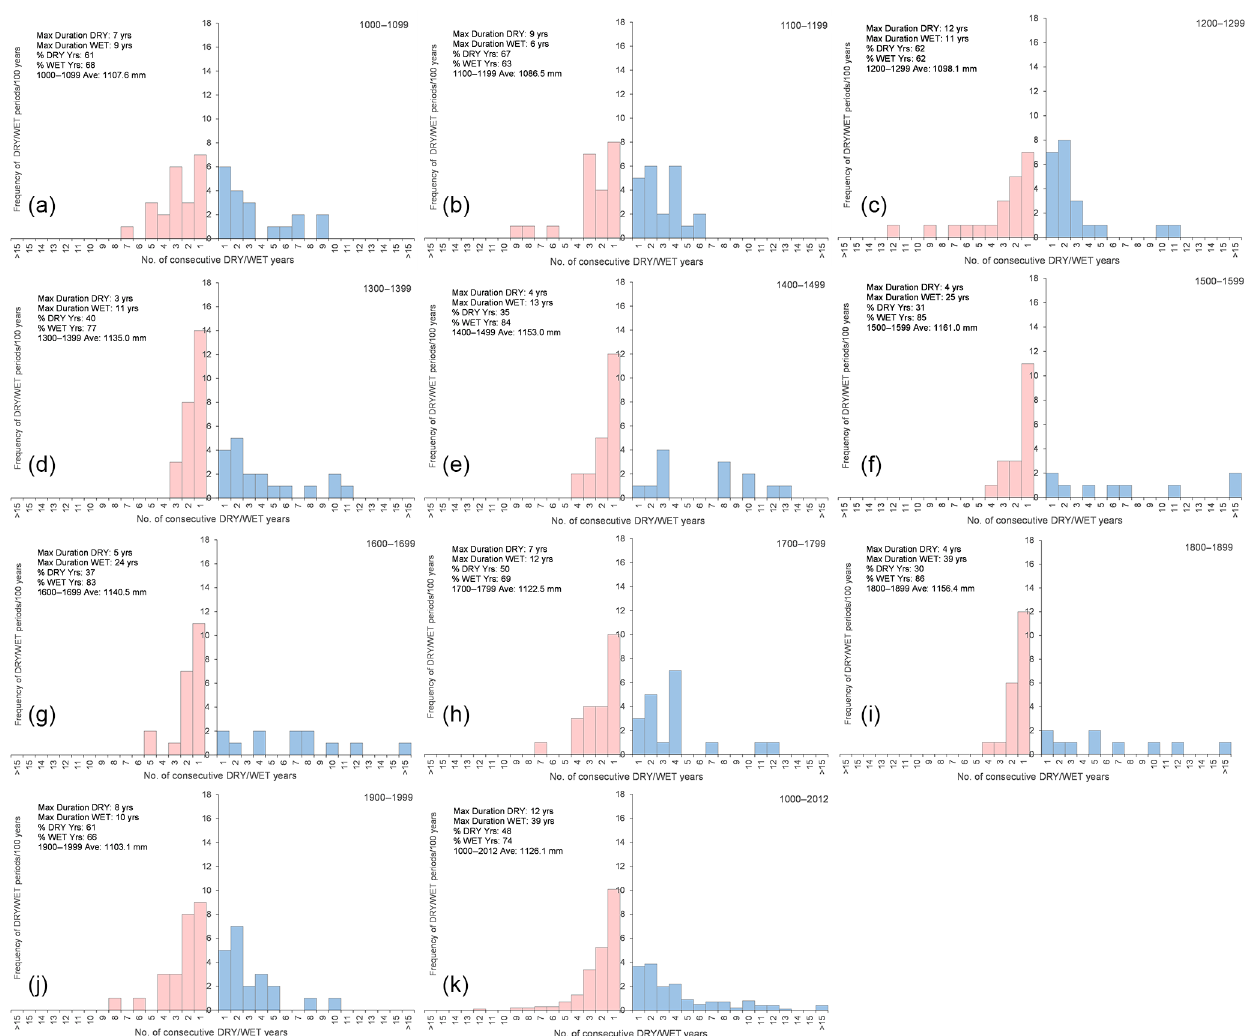
Figure 7. Histograms of duration of WET (blue) and DRY (pink) average periods during each century since CE1000. (a) – (j) are centennial subsets and (k) is theCE 1000–2012 period (note different axis scaling). WET/DRY are defined using x = 0 . 3 in Eq. (1) (as per Table